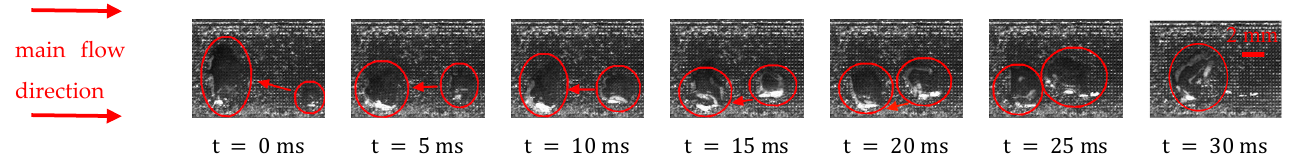
Figure 17. Schematic diagram of the flow field in which the bubbles are located. 3.5. Effect of Reynolds Number on Bubble Oscillation Amplitude and Shape The deformation of bubbles is studied by the aspect ratio E analysis, as shown in Figure 18. When the bubble volume no longer increases at each Reynolds number, the